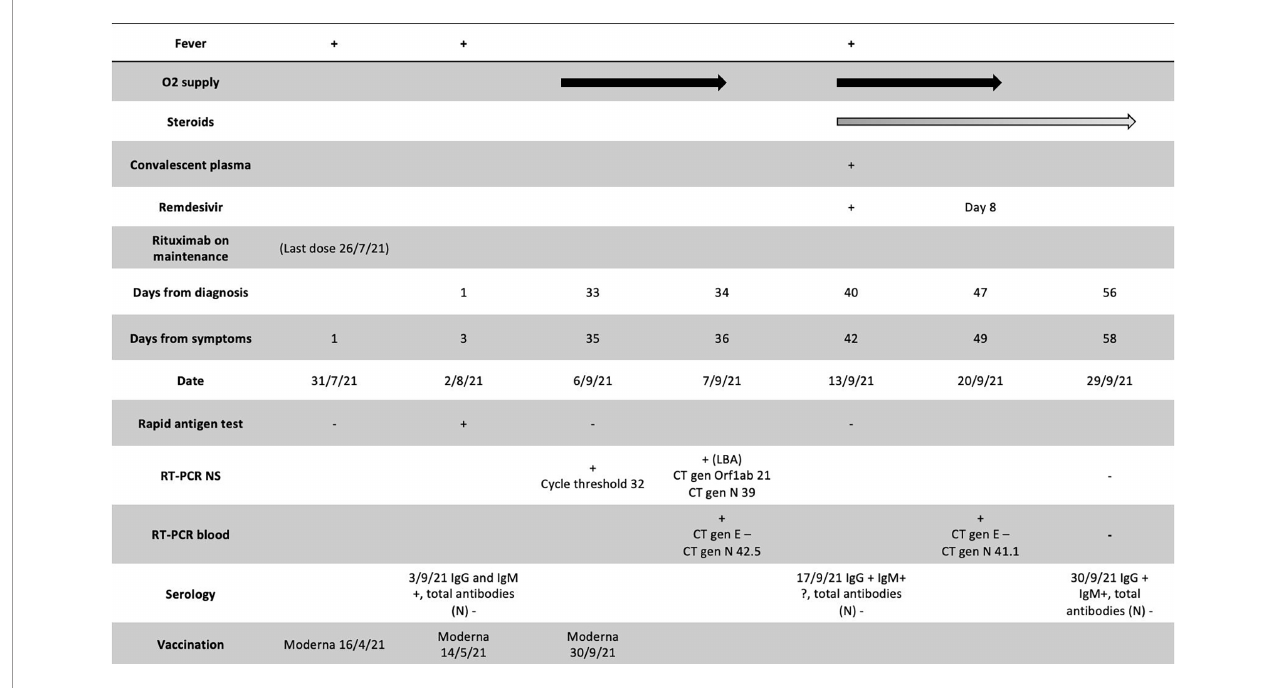
FIGURE 4 | A timeline of the case 2; administered treatments, O2 supply, Rituximab administration, serology , date of vaccination and diagnosis test ( Rapid Antigen Test and RT-PCR in nasopharyngeal swabs (NS) and plasma). RT-PCR, real-time polymerase chain reaction; CT, Cycle threshold values; N,